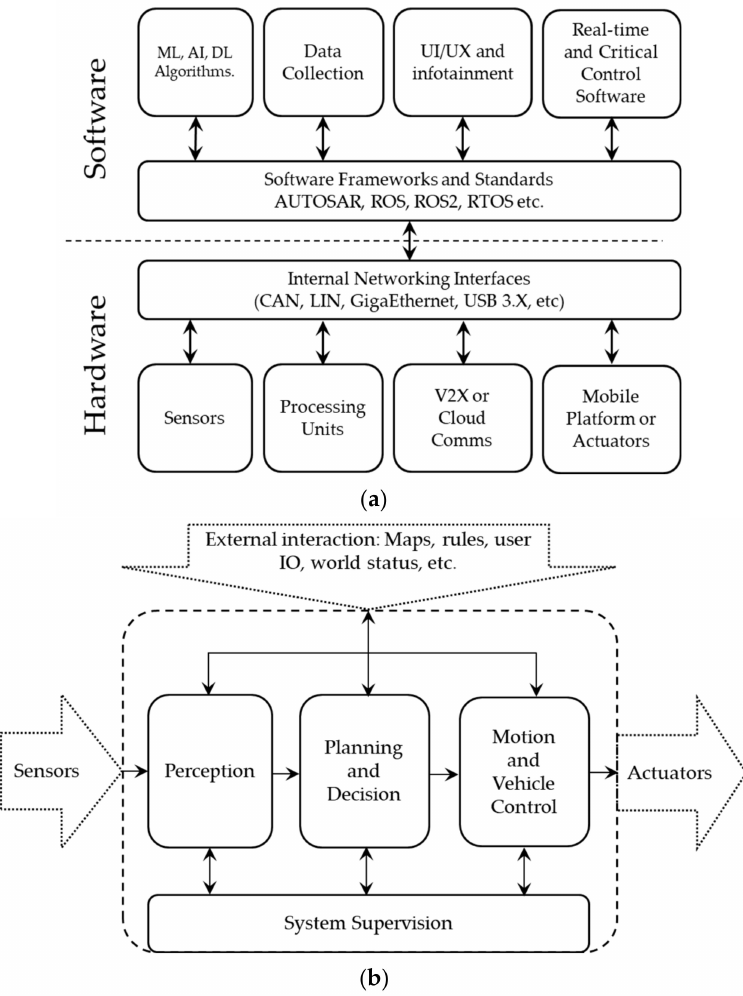
Figure 2. Architecture of an autonomous driving (AD) system from, ( a ) a technical perspective that describes the primary hardware and software components and their implementations; ( b ) a functional perspective that describes the four main functional blocks and the flow of information based on